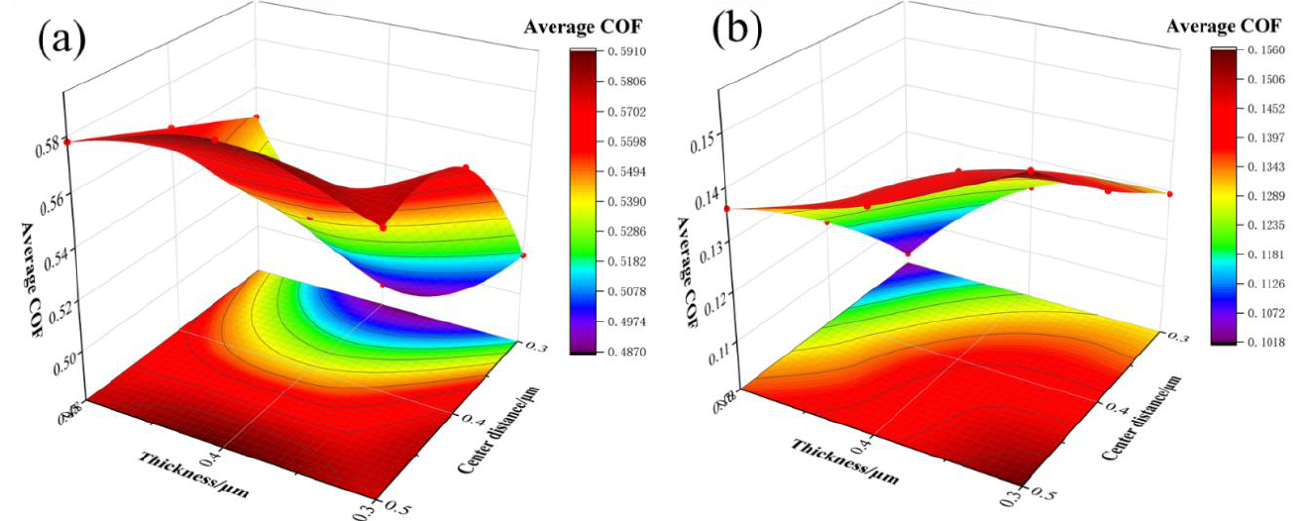
Figure 3. Average friction coefficient influenced by sample thickness and center distance of weave ( a ) Mn-Cu samples, ( b ) Fe-Zn samples.